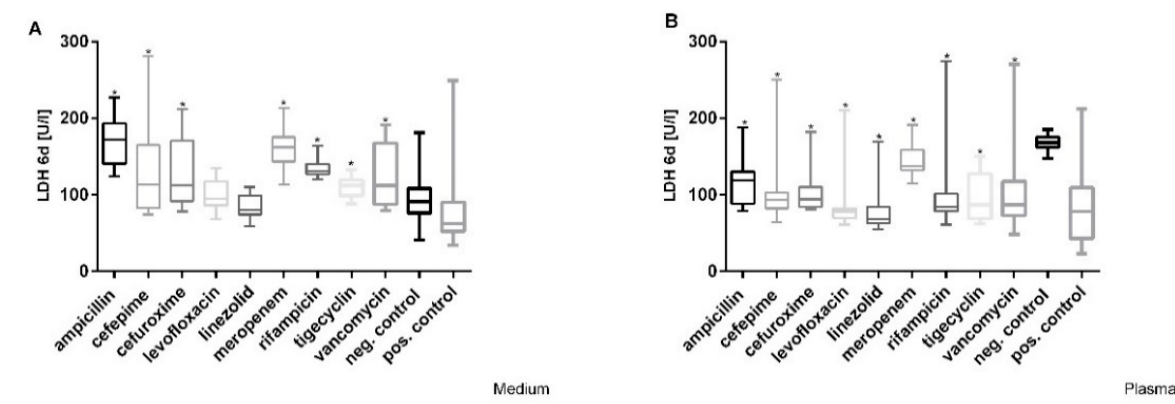
Figure 3. Effects of varying Cmax antibiotic concentrations on LDH release in ( A ) medium and ( B ) plasma in HepG2/C3A cells during 6 days of treatment. Values represent median and 25th/75th percentile of three replicate wells from four experiments. Significance difference between control and exposure groups is indicated by * p < 0.05.